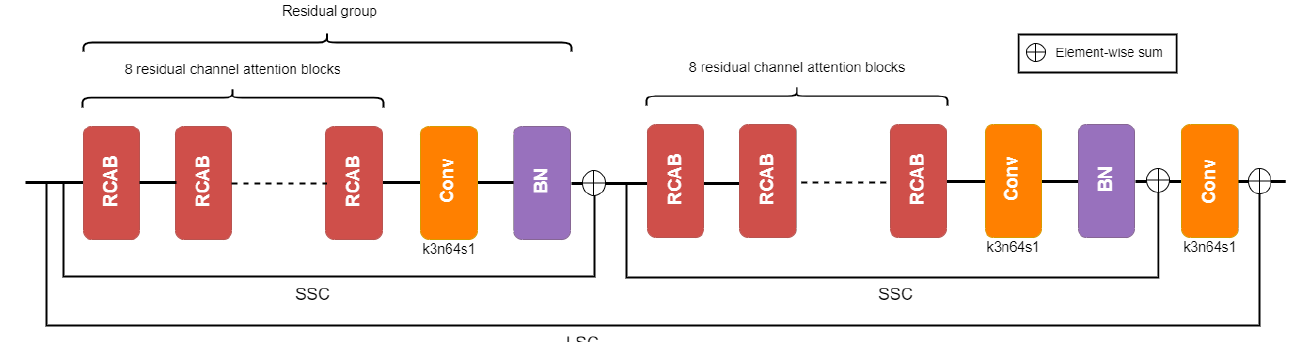
Figure 7. Residual structure of the model using two residual groups, each of them formed by 8 residual channel attention blocks. These residual groups are followed by a convolutional layer.